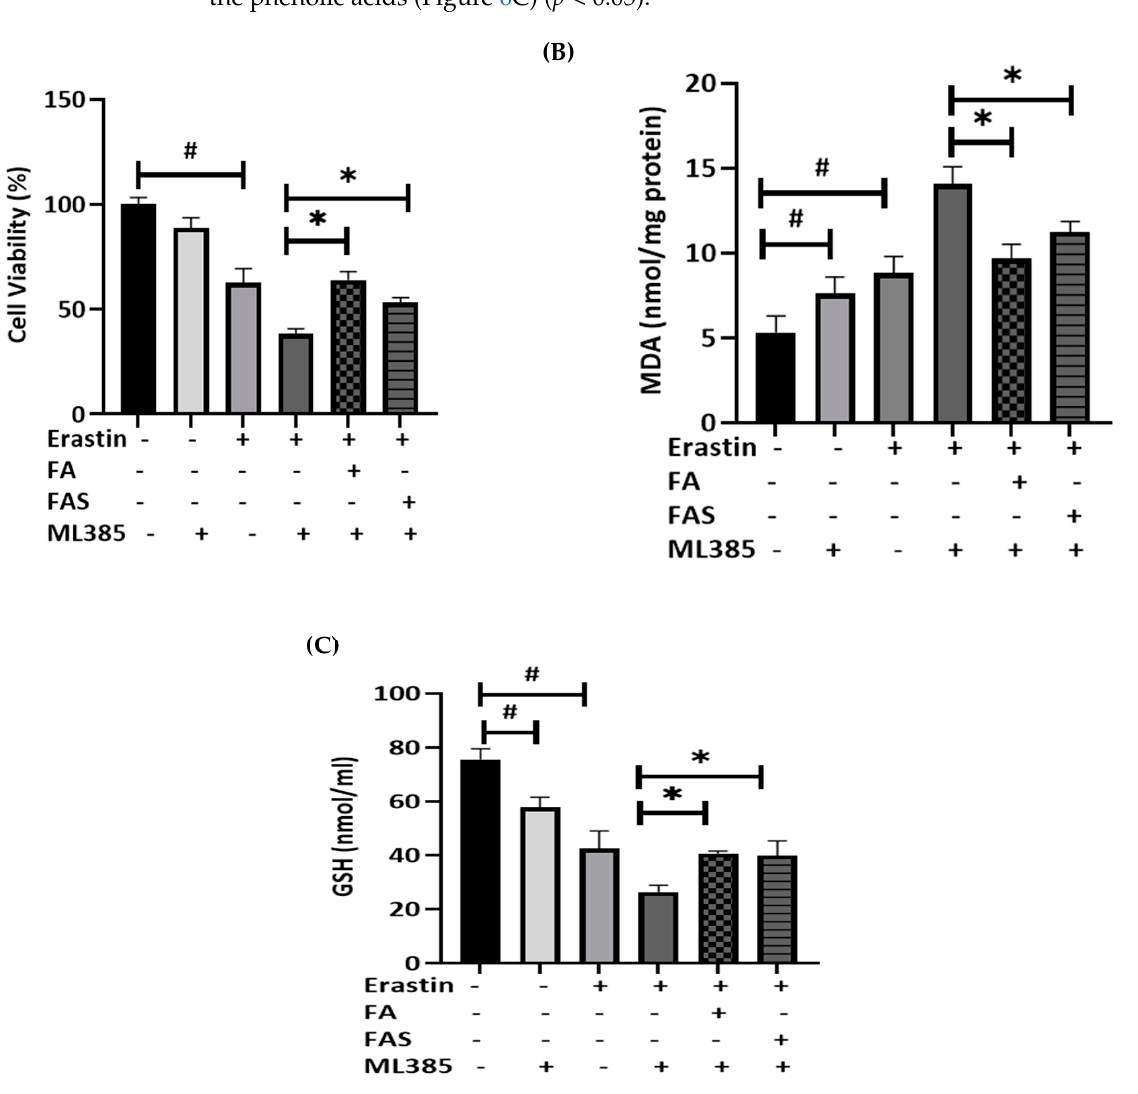
Figure 6. Phenolic acids protect MIN6 cells treated with ML385, an Nrf2 inhibitor against ferroptosis markers. Cells were treated with 10 µ M of Nrf2 inhibitor, ML385, for 2 h before ferroptosis treatment. Then, MIN6 cells were exposed to 20 µ M of erastin in the absence and presence of 20 µ M of ferulic acid (FA) or ferulic acid 4-O-sulfate disodium salt (FAS) for 24 h. Cell viability was presented by MTT assay ( A ), lipid peroxidation was analysed by MDA assay ( B ), and total glutathione (GSH) amounts ( C ) was measured by GSH assay. All the values are expressed with the mean ± SEM. # p < 0.05 controls vs. treatment groups; * p < 0.05 erastin only vs. treatment groups. One-way ANOVA, Tukey’s post hoc test.